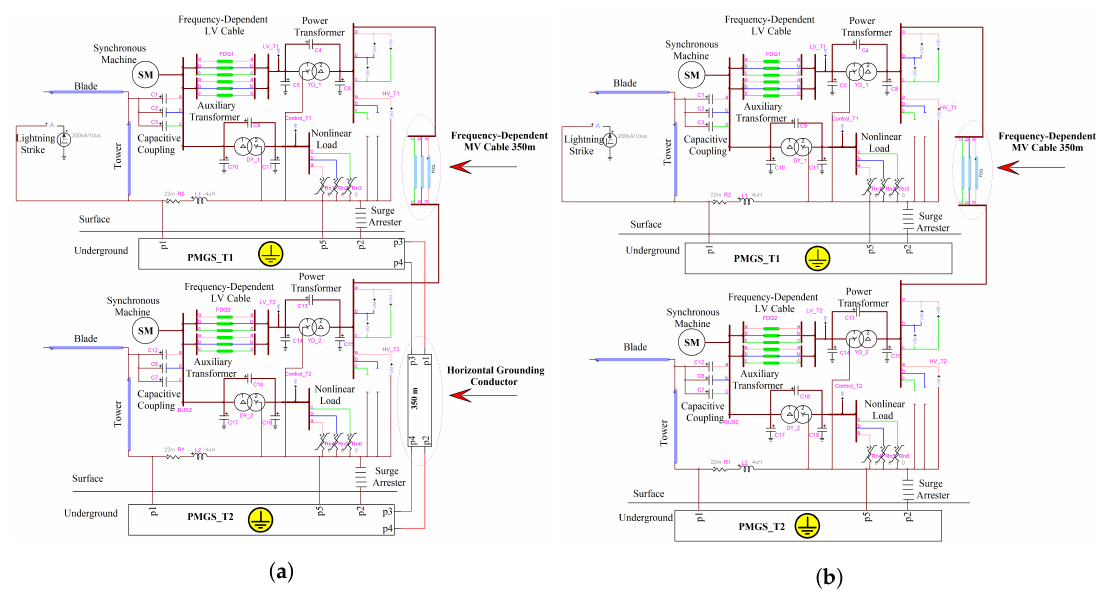
Figure 15. EMTP-RV circuit of the pair of turbines. ( a ) Interconnected PMGS; ( b ) separated PMGS.